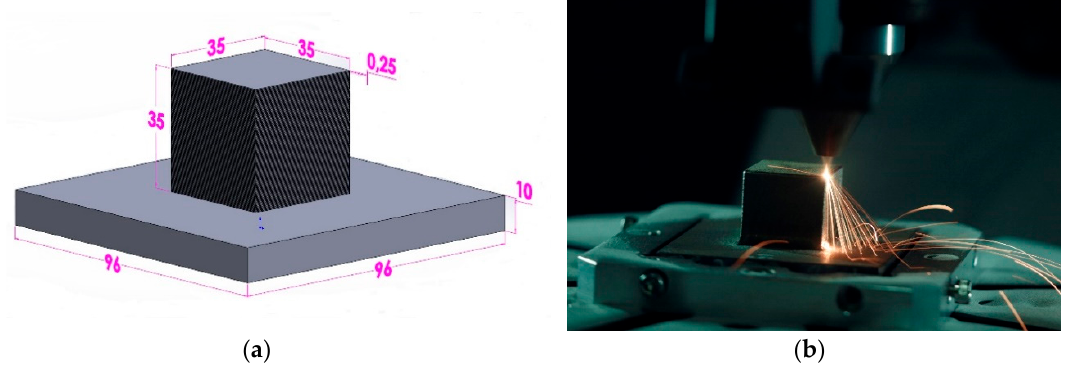
Figure 14. ( a ) A CAD model of the cubic structure with dimensions in millimeters; ( b ) 3D cubic structure deposition.